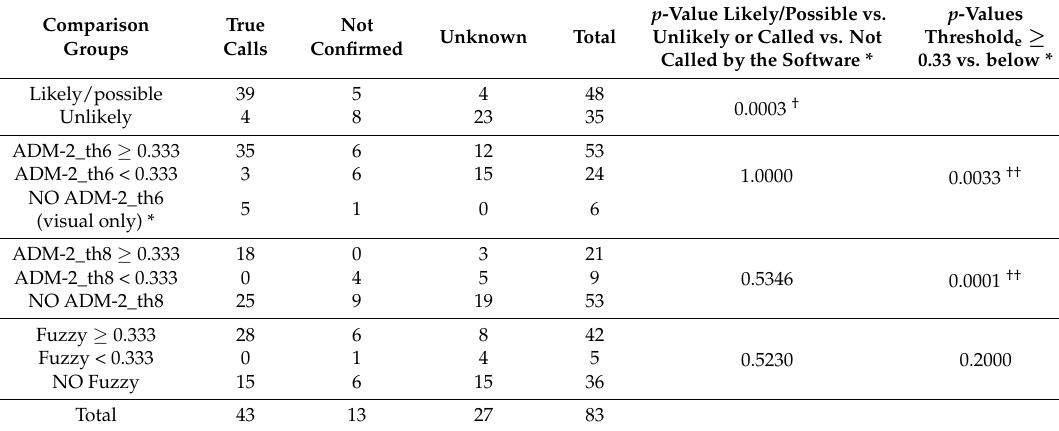
Table 3. Detection filters